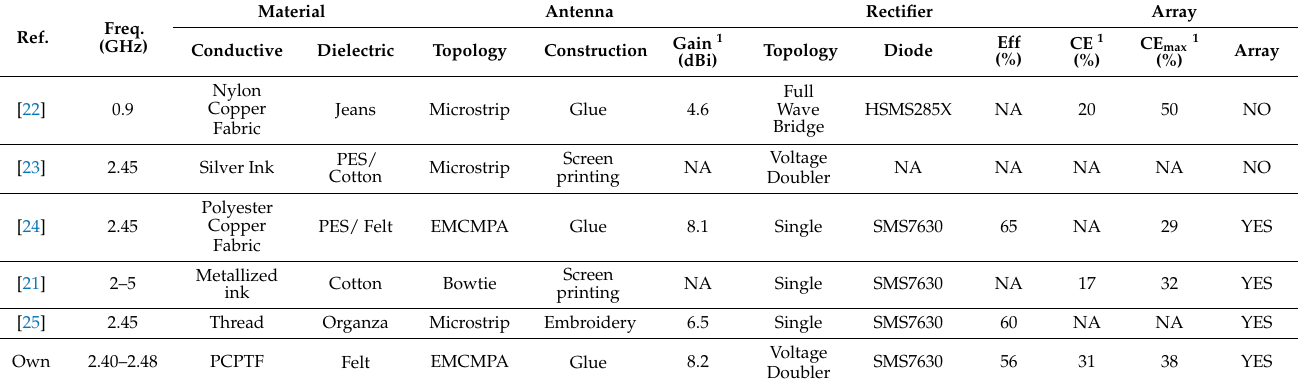
Table 1. Comparison between literature and proposed textile